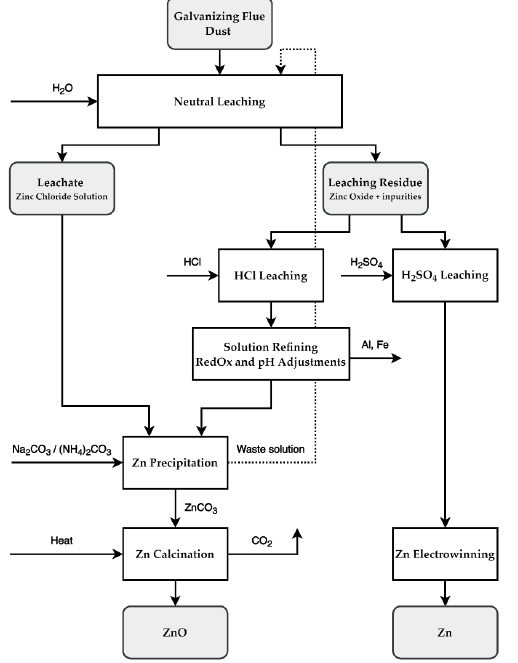
Figure 6. Proposed recycling method of Zn from galvanizing flue dust.